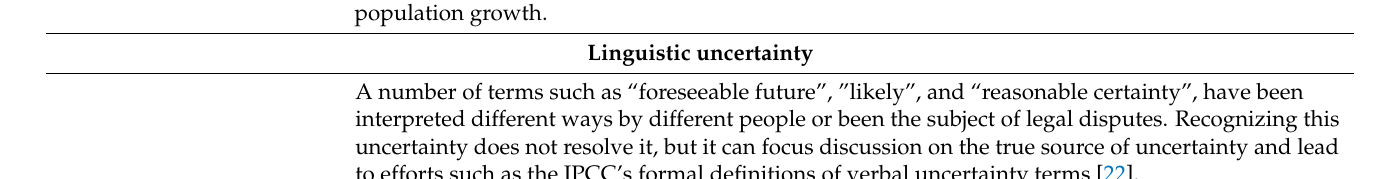
Uncertainty about How the System Works